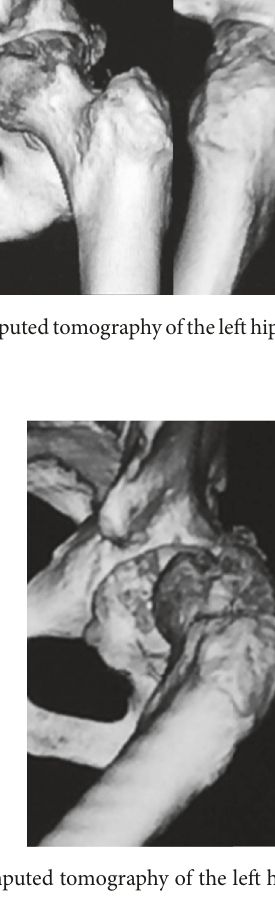
Figure 4: Removed femoral head. The depressed fracture in the femoral head is observed.